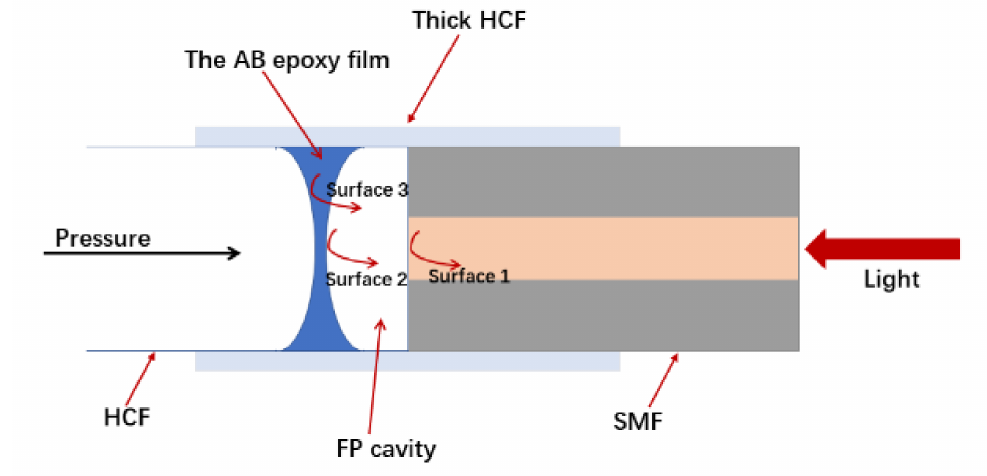
Figure 1. Schematic diagram of the sensing structure. There are three reflective surfaces: Surface 1, Surface 2, and Surface 3 [27]. When the light is coupled to the core of the SMF, it encounters the first reflection surface 1 (the end face of the SMF) and the second reflection Surface 2 (inside the AB epoxy film) after passing through the FP cavity. Light passes through the AB epoxy film to reach the third reflective Surface 3 (outside of the AB epoxy film) on the far end surface, and the beams of the three reflecting surfaces form the interference